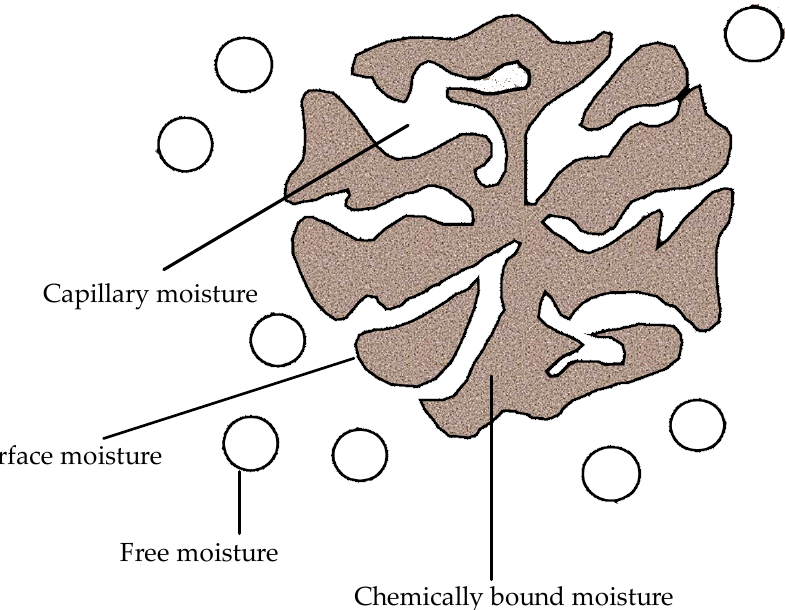
Figure 10. Schematic representation of different types of moisture distribution within coal fines [44]. Table 9. Water absorption of different materials.